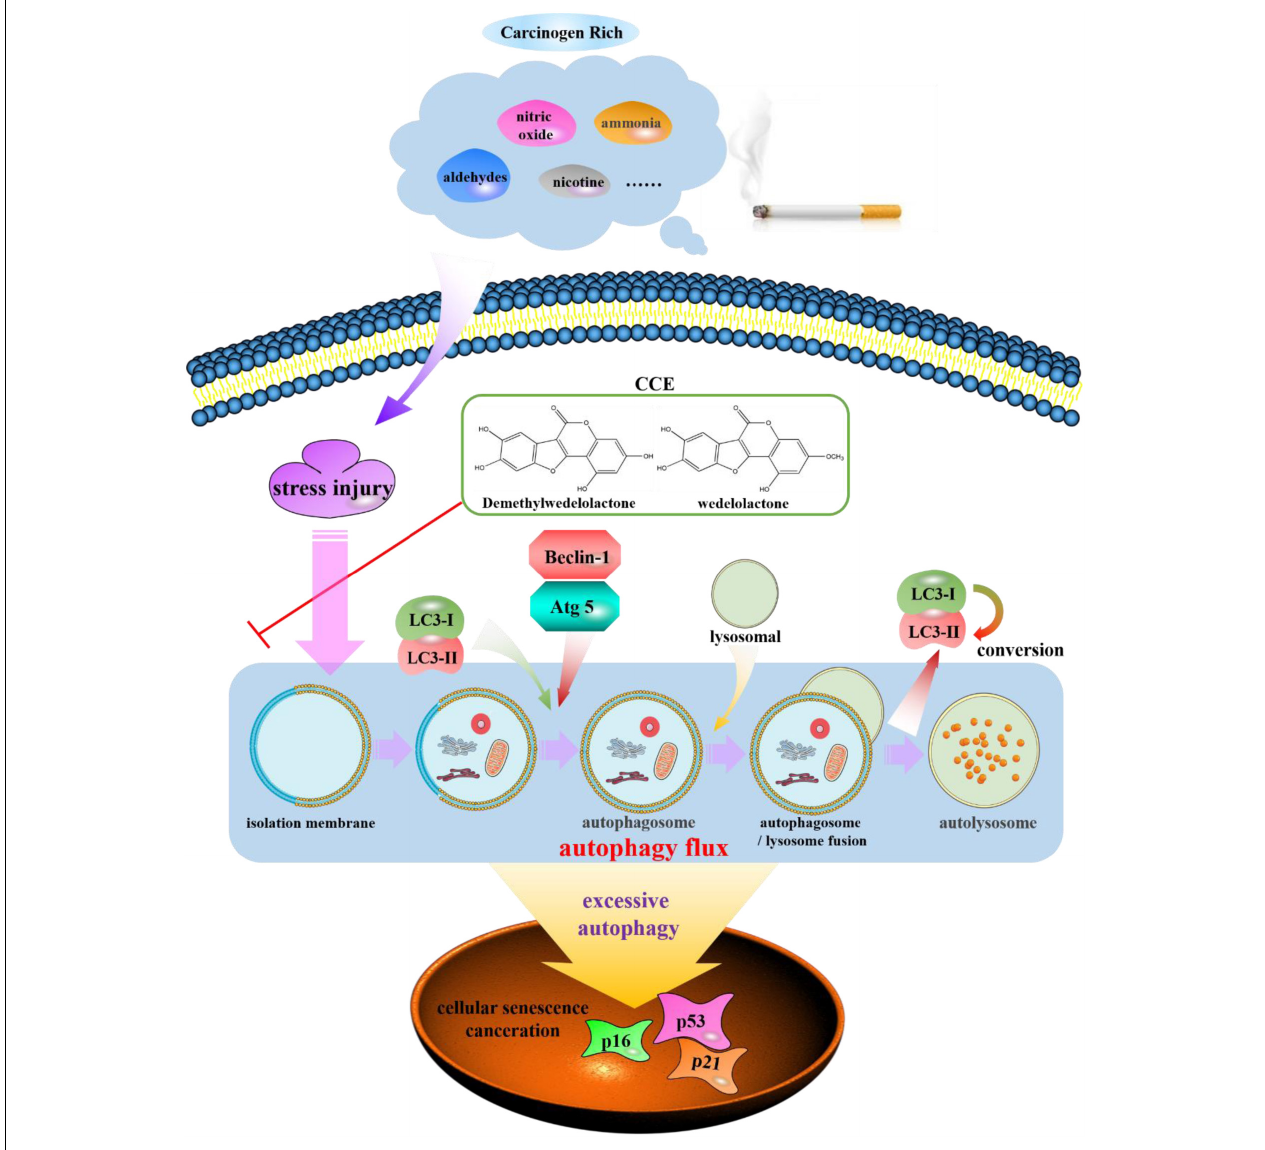
FIGURE 9 | Schematic diagram of autophagy flux contributes to a regulation of CCE on cigarette smoking-induced injury of NHBE